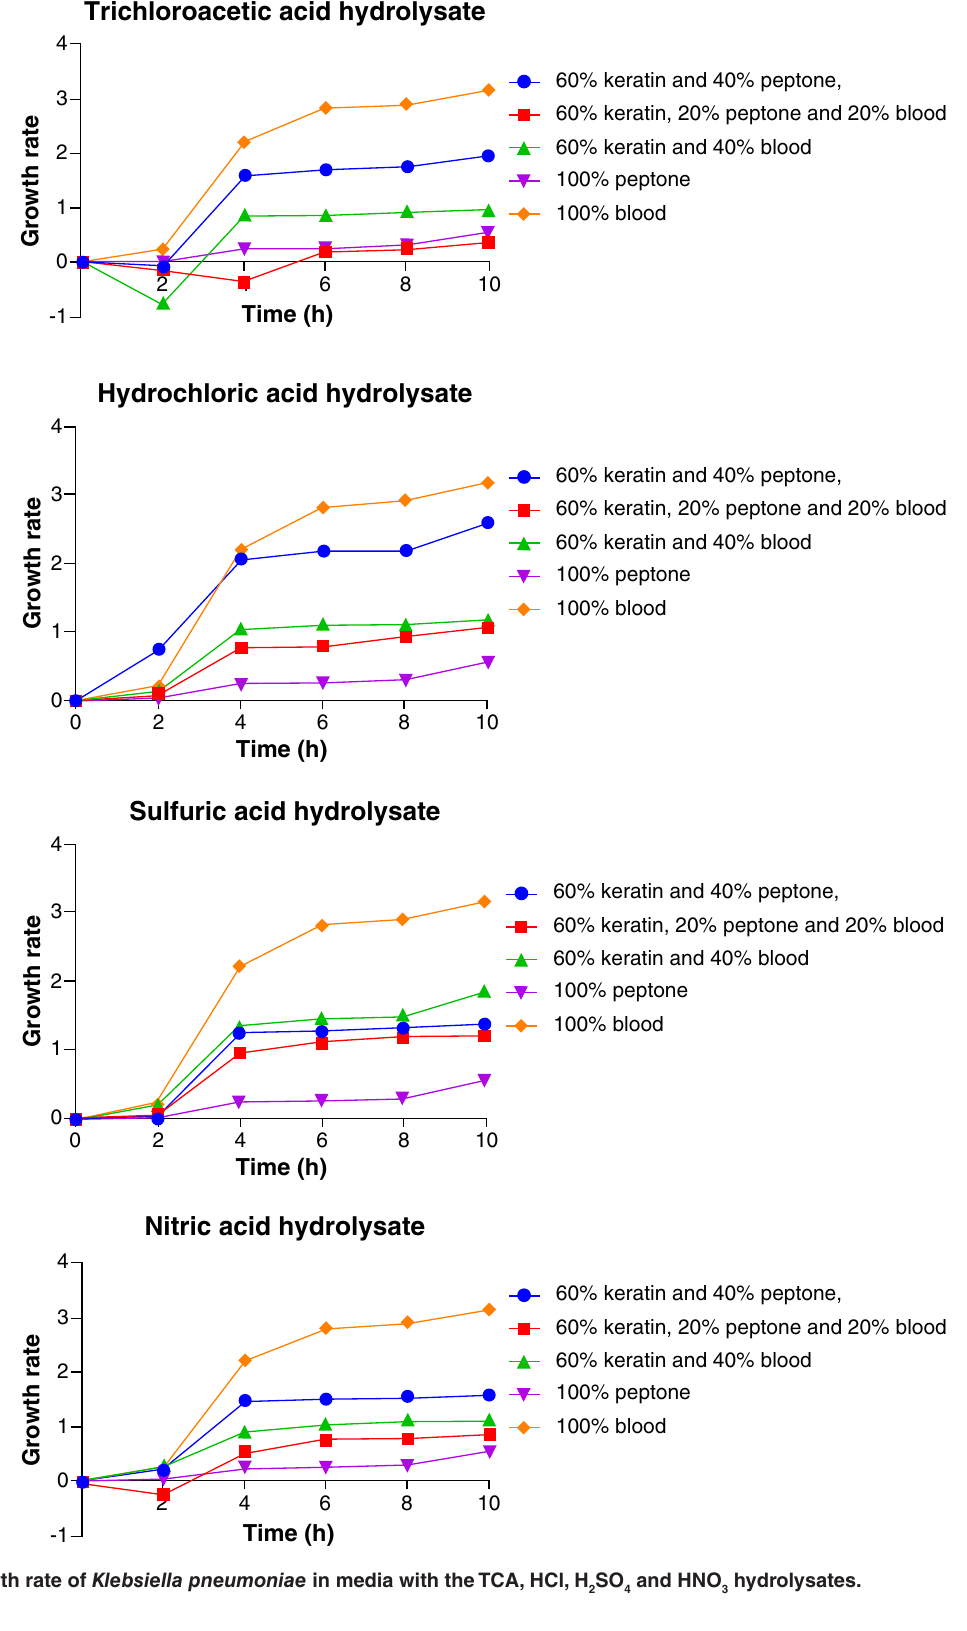
Figure 4. Growth rate of Klebsiella pneumoniae in media with the TCA, HCl, H